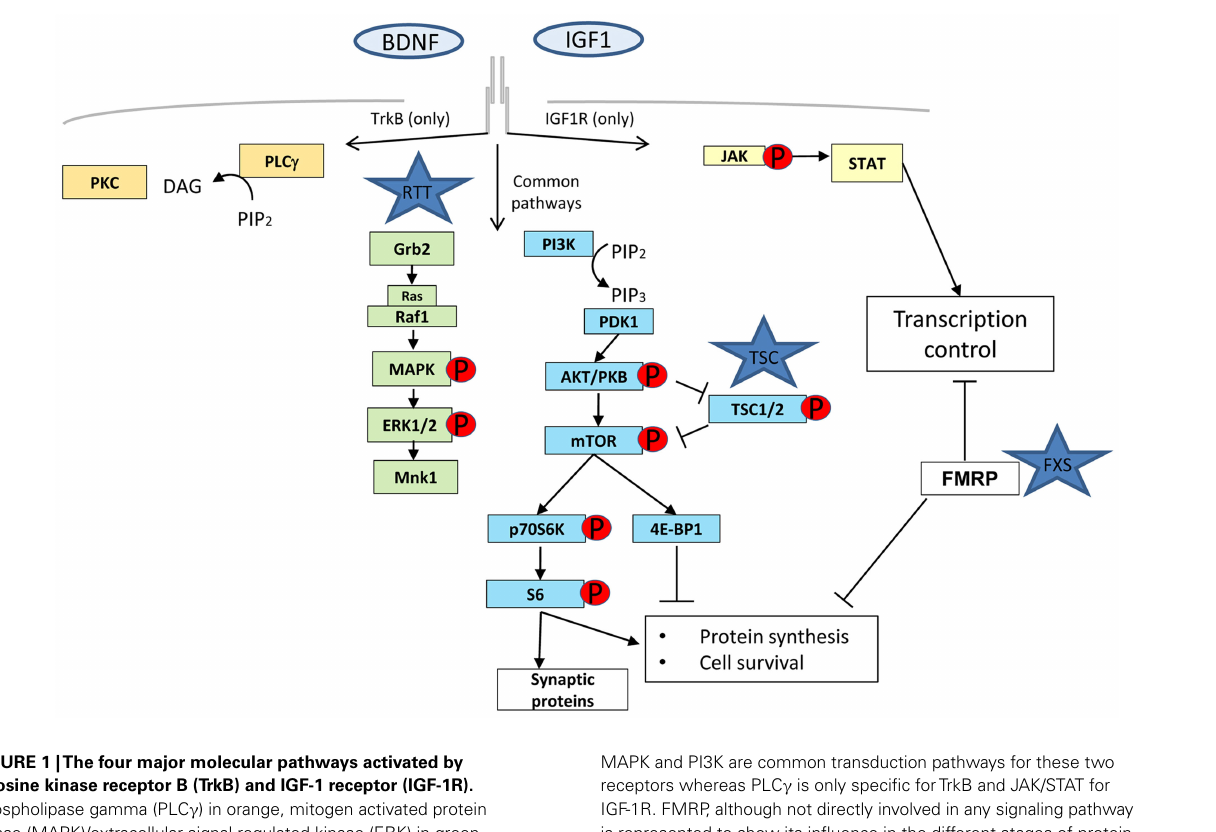
FIGURE 1 |The four major molecular pathways activated by tyrosine kinase receptor B (TrkB) and IGF-1 receptor (IGF-1R). Phospholipase gamma (PLC γ ) in orange, mitogen activated protein kinase (MAPK)/extracellular signal-regulated kinase (ERK) in green, Phosphatidylinositol-3 kinase (PI3K)/Akt in blue, and Janus kinase (JAK)/signal transducer and activator of transcription (STAT) in yellow.